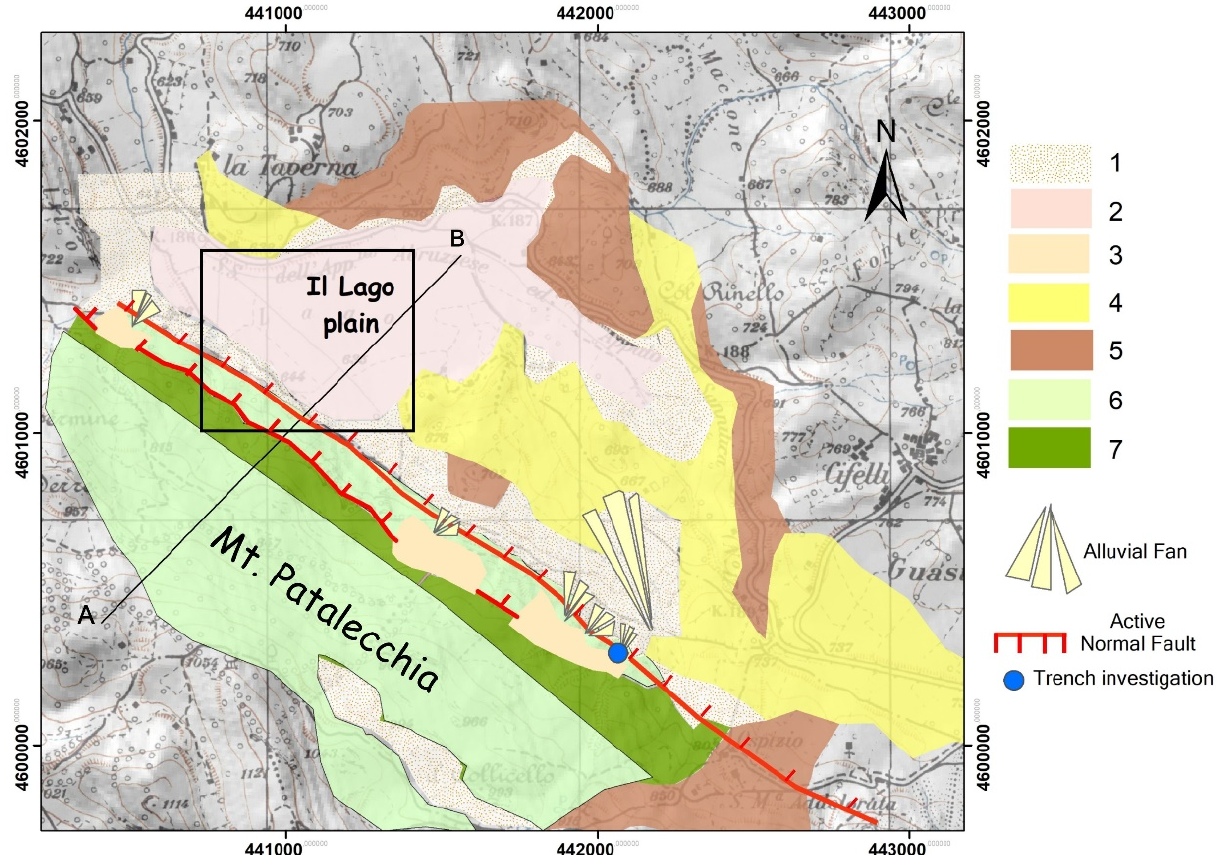
Figure 2. Geological sketch map of the investigated area: (1) colluvial and slope debris deposits (Holocene); (2) lacustrine deposits (Late Pleistocene to Holocene); (3) cemented limestone breccias (Middle to Late Pleistocene); (4) Calcarenites, calcilutites, and marly limestone (Serravallian–Tortonian); (5) marly limestone and marl (Oligocene–Burdigalian); (6) calcarenites and cherty limestones (Senonian-Turonian); and (7) Mesozoic limestone succession (Cenomanian–Early Turonian) modified after [16,49]. The black rectangle in the map is the area shown in Figure 3; the black line is the trace of the geological cross-section of Figure 14; the blue dot is the trench investigation site is from [27]. Easting and northing are UTM WGS 84.